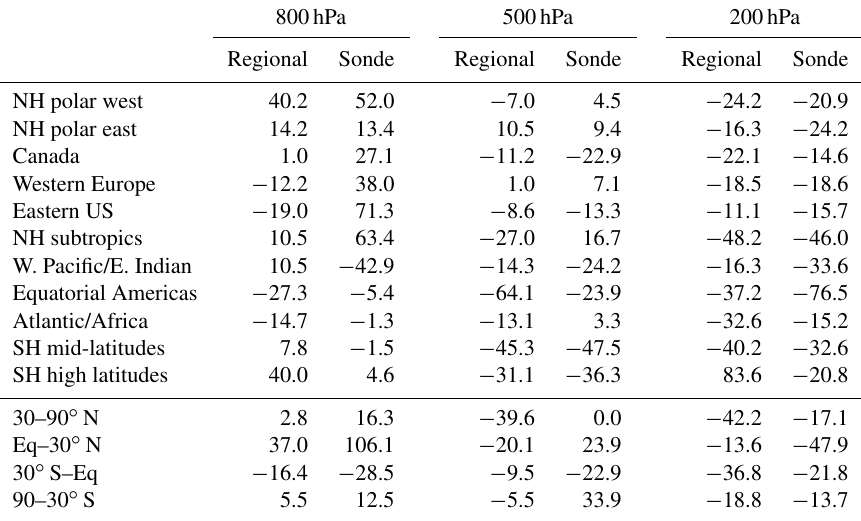
Table 10. ACCMIP multi-model mean minus reanalysis comparisons of the seasonal amplitude of regional mean ozone concentration (in %) for the regional average (Regional) and at the ozonesonde sampling (Sonde). The seasonal amplitude is estimated as a difference between maximum and minimum monthly mean